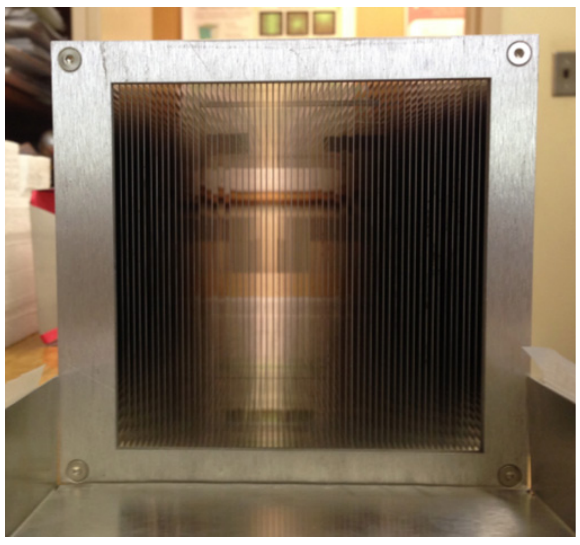
Figure 2. Front view of the SM. The image seen through the SM is deflected by 13mrad.